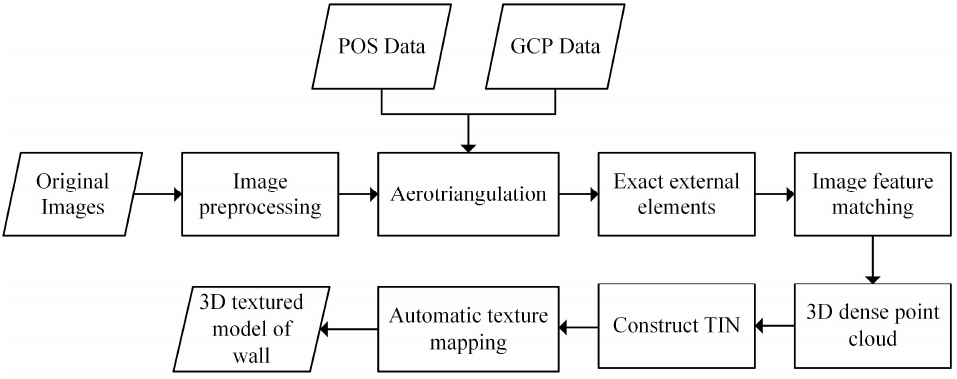
Figure 10. Data processing process of oblique images.